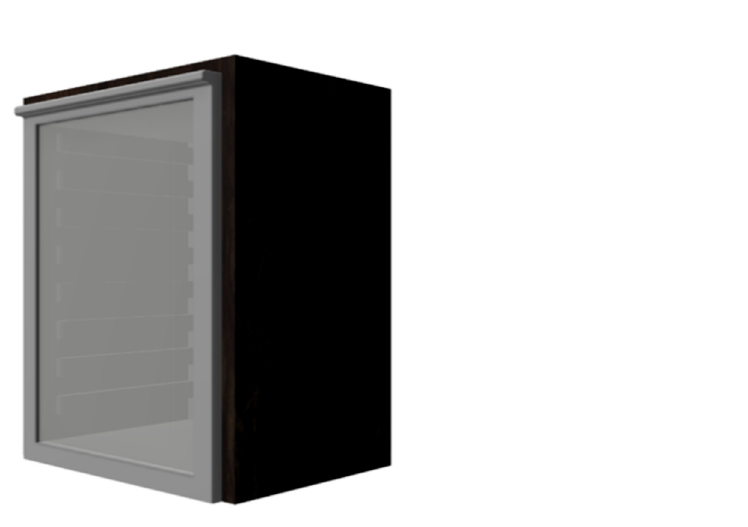
Figure 3. Refrigerator in wooden casing, right side view.